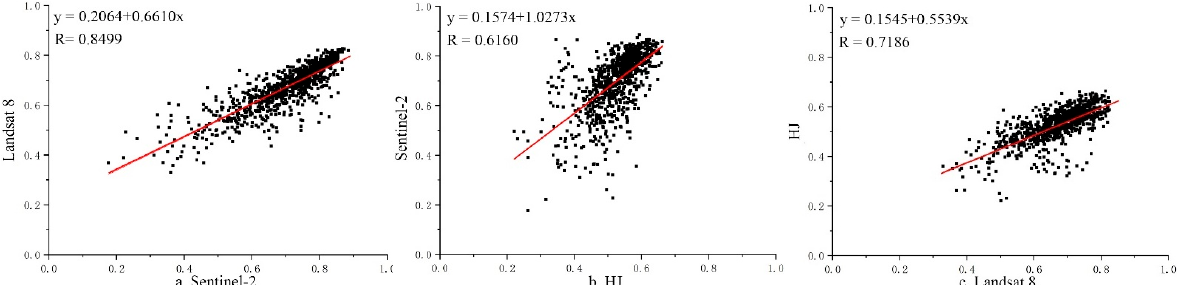
Figure 6. Correlation analysis of NDVI value based on random points (The figures include the con- version equation and correlation coefficient between every pair of sensors for NDVI. ( a ) shows the fitting result of NDVI between Landsat 8 and Sentinel-2; ( b ) shows the fitting result of NDVI be- tween Sentinel-2 and HJ; ( c ) shows the fitting result of NDVI between HJ and Sentinel-2). Table 4. The NDVI fitting results of the West Dump under multi-source sensor monitoring. Satellite Sensor R 2 Correlation Coefficient Landsat 8 and Sentinel-2